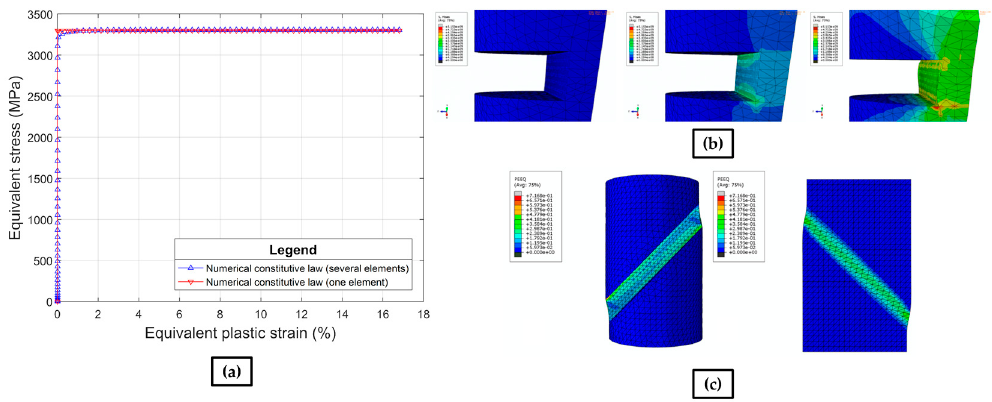
Figure A4. Numerical results for: ( a ) the equivalent Huber-Mises stress versus equivalent plastic strain, where one curve is being averaged in the ligament and the other one is the output of a single element; ( b ) the equivalent stress field in the notched section of the sample ( t = 0 (left), 22 µs (middle), and 100 µs (right); ( c ) the equivalent plastic strain in the sample.